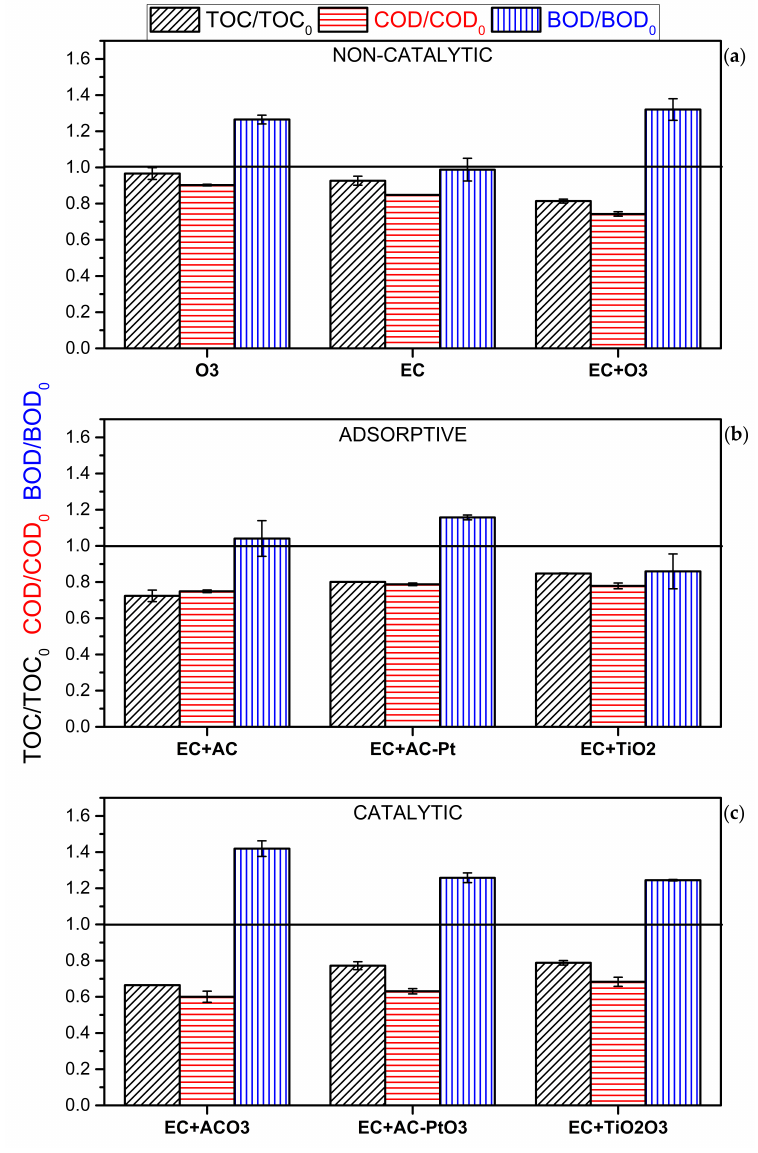
Figure 4. The values of TOC / TOC 0 , COD / COD 0 , and BOD / BOD 0 after the treatments ( a ) non-catalytic ( b ) adsorptive, and ( c )